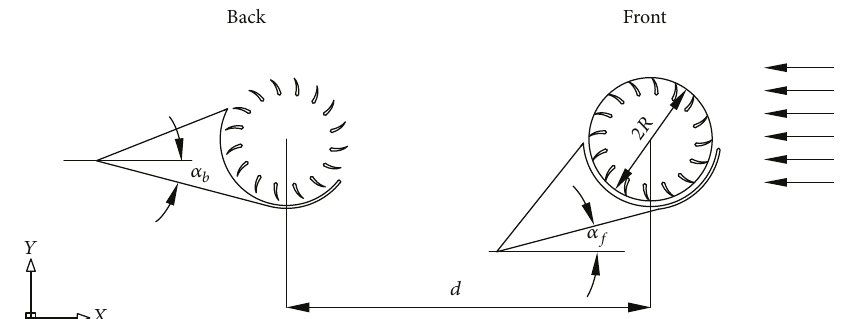
Figure 11: De fi nition of the angle between the front and rear wings of the tandem fan wing.